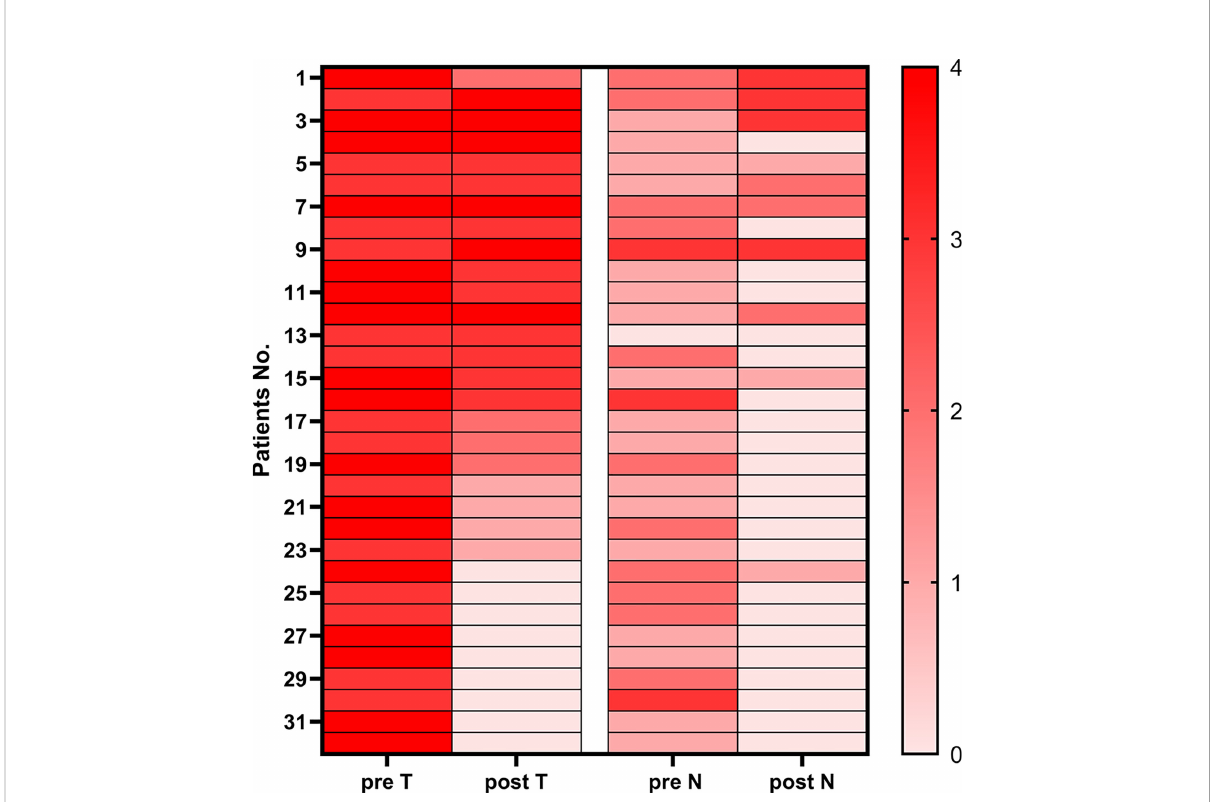
FIGURE 3 Heatmap of pre-therapy and post-therapy T&N stages of patients with gastric cancer and gastroesophageal junction